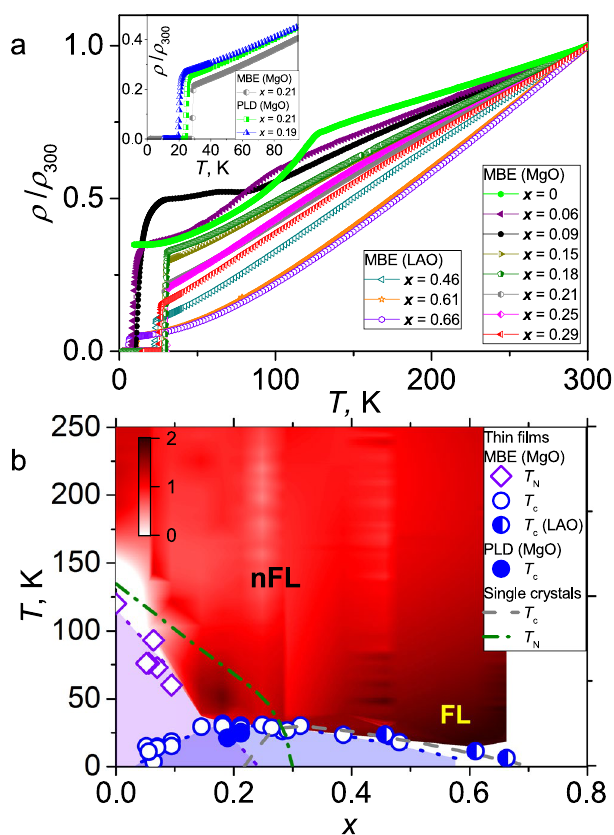
Figure 1. ( a ) The temperature dependence of the normalized resistivity ρ / ρ 300K of BaFe 2 (As 1 − x P x ) 2 films prepared by MBE. Closed symbols - underdoped, half closed symbols - optimally doped, and open symbols - overdoped samples. Inset: The normalized resistivity traces for BaFe 2 (As 1 − x P x ) 2 thin films with the similar P-doping prepared by PLD and MBE. ( b ) The phase diagram of BaFe 2 (As 1 − x P x ) 2 thin films (symbols). The data of BaFe 2 (As 1 − x P x ) 2 single crystals (dashed lines) 14, 25 are also shown for comparison. The whole phase diagram for the thin films prepared on MgO substrates is shifted to lower doping levels compared to that of the single crystals and films prepared on LAO substrates. The shift of the phase diagram is substrate-dependent due to different in-plane strains. The contour plot of the doping and temperature dependence of the exponent n is obtained from the data shown in Fig. 1a and in ref. 23 assuming ρ = ρ 0 + AT n . The position of the QCP is around x c ~ 0.25 for the films prepared on MgO substrates. The positions of the QCP for the single crystals and films prepared on LAO substrates do nearly coincide at x c ~ 0.30. For further details see text. The doted lines are guides to the